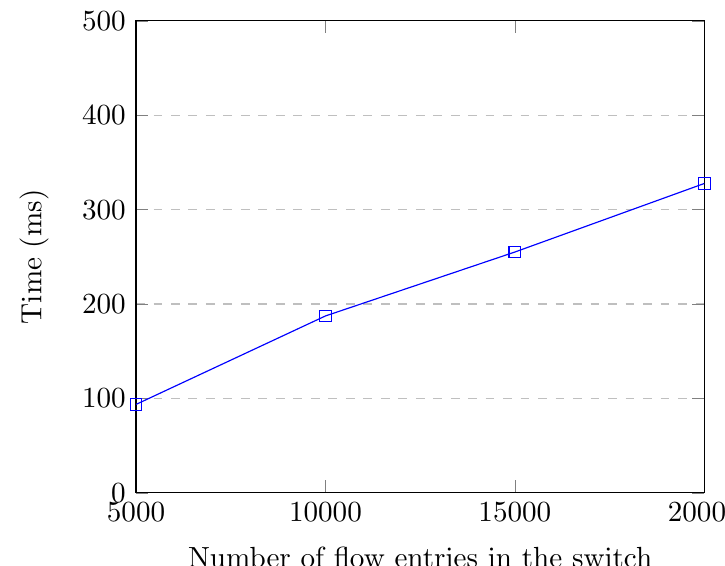
Figure 14. Feature retrieval time of 10 best features up to 20,000 flow entries.